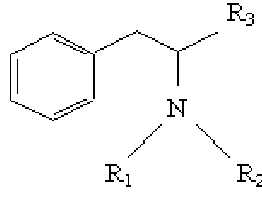
Figure 1. Molecular structures of the main amphetamines